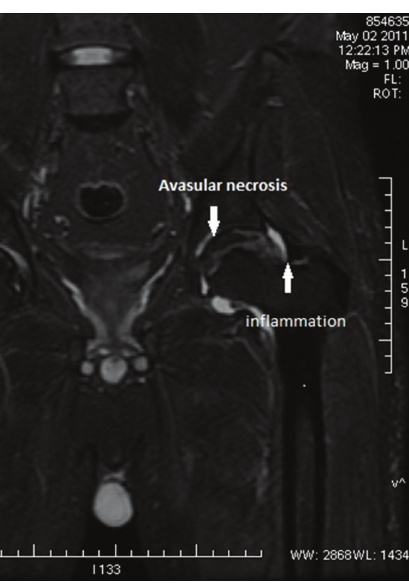
Figure 1: Magnetic resonance imaging (MRI) showing avascular necrosis and inflammation of the left